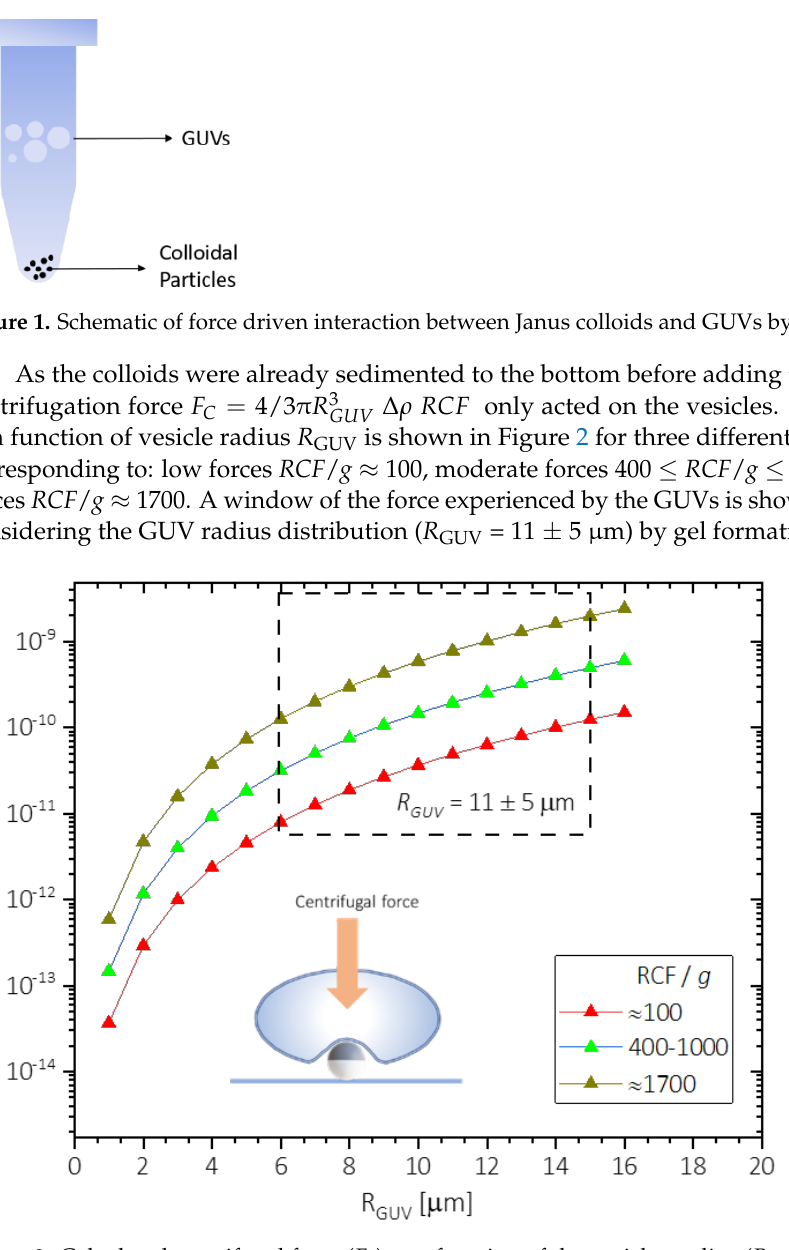
Figure 2. Calculated centrifugal force ( F c ) as a function of the vesicles radius ( R GUV ) for different relative centrifugation force, RCF .